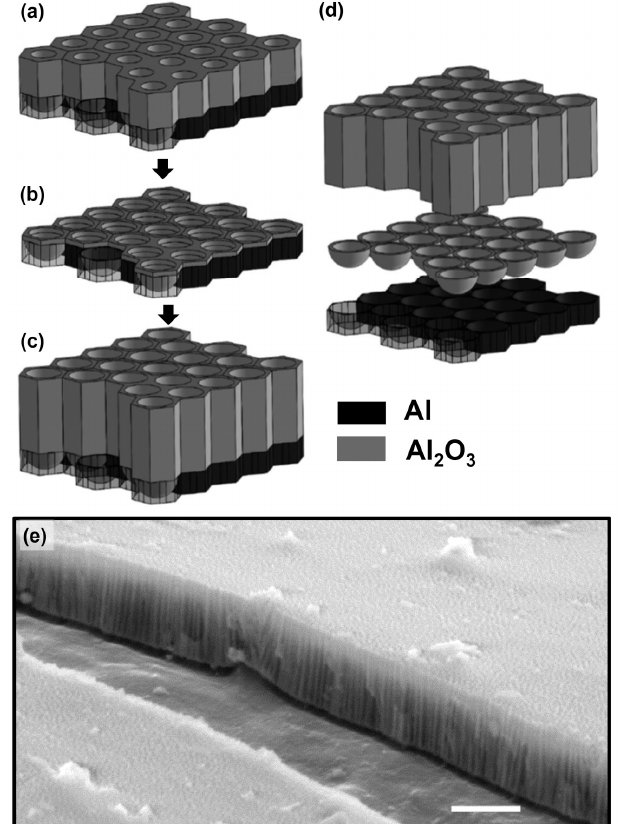
Figure 1. Fabrication processes of anodic aluminum oxide (AAO) template and the corresponding structures. ( a ) the 1st anodization to establish the electron density distribution over aluminum substrate; ( b ) etching procedure to create regularly allocated nano-bowls (i.e., barriers); ( c ) the second anodization at the same parameters as those used in (a) to create AAO nano-pores. ( d ) Sketch of sample AAO structures: from top to bottom are nano-tubes of alumina ( Al 2 O 3 ) , alumina nano-bowls (barrier layer), and aluminum substrate. Color-coded by materials: (black) aluminum and (gray) alumina. ( e ) SEM micrograph of an AAO template anodized at 40 V at 1 ◦ C in 0.3 M oxalic acid. The template was cleaned afterward with a reverse anodization process at − 2 V at 20 ◦ C in 0.2 M KCl solution for 150 s. Scale: 1 µ